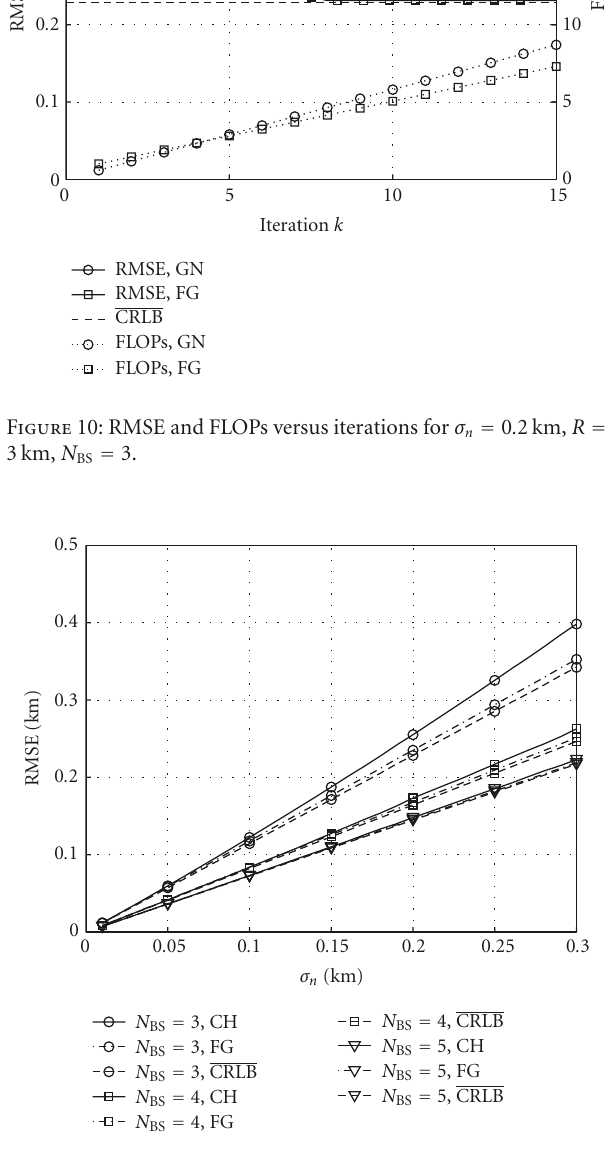
Figure 11: RMSE versus σ n for FG and CH algorithms, R = 3km.